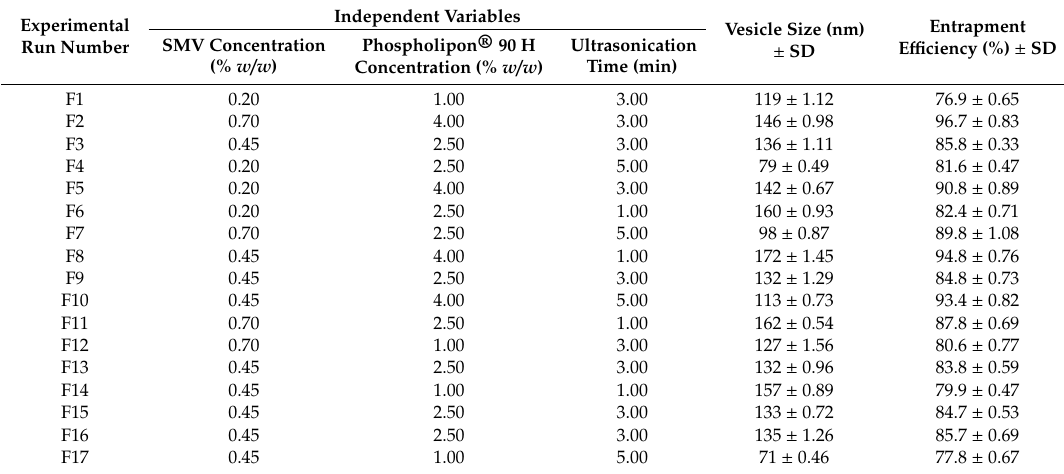
Table 2. Experimental runs, variables levels, and observed responses of SMV-EMLs prepared according to Box–Behnken